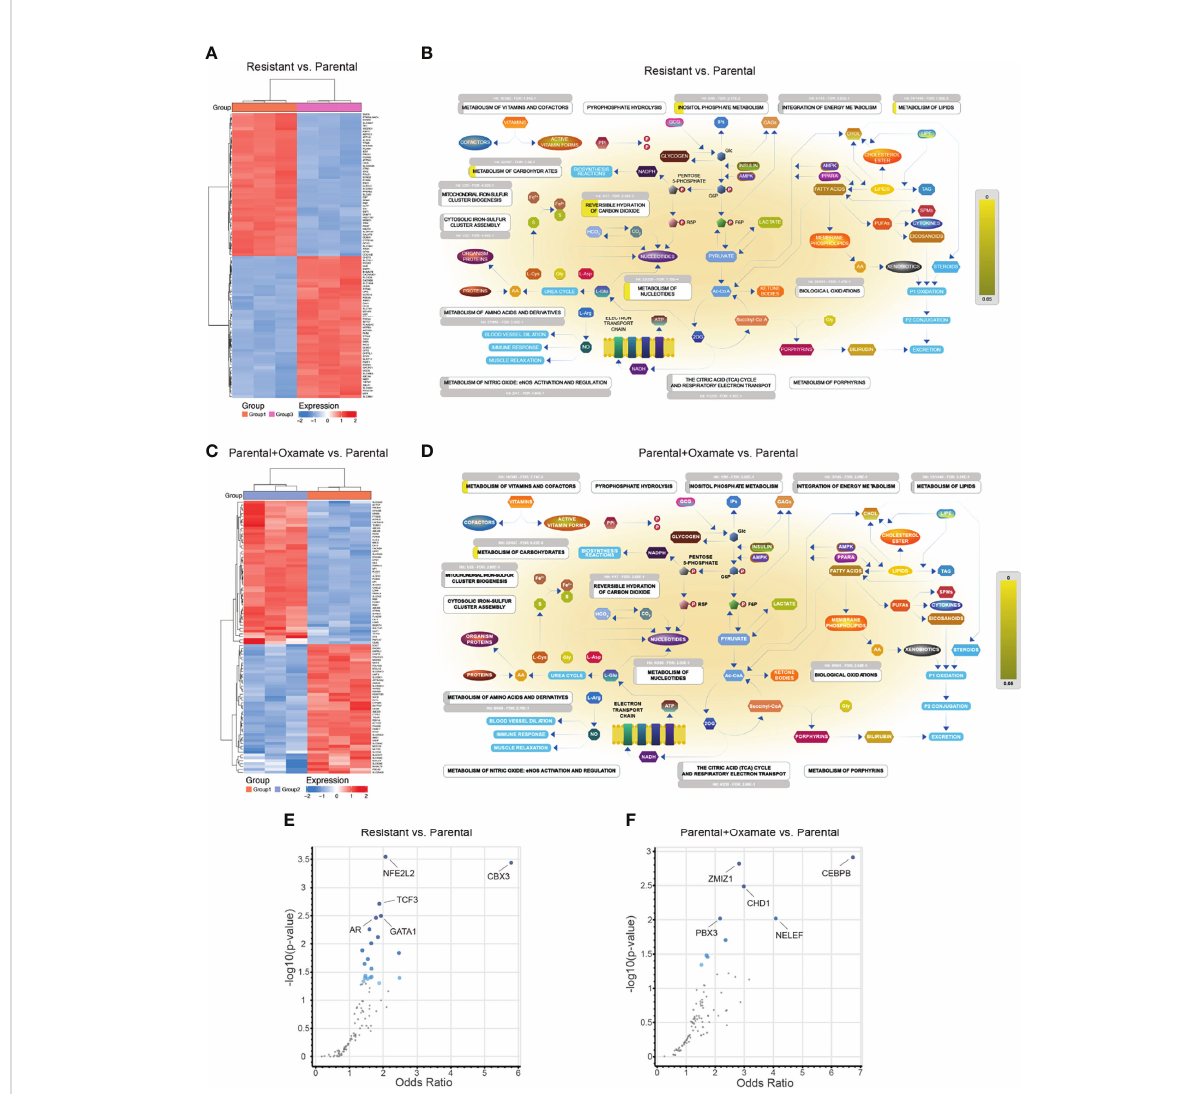
FIGURE 8 Alternations in metabolic genes and their potential transcriptional regulators in parental/resistant cells and parental/oxamate-treated parental cells. (A) Heatmap showing the expression of the top 100 (50 upregulated and 50 downregulated) differentially expressed metabolic genes between parental and oxamate-resistant MIAPaCa2 cells. (B) Reactome Pathway Analysis for differentially expressed metabolic genes between parental and oxamate-resistant MIAPaCa2 cells shows key metabolic pathways associated with signi fi cantly enriched genes (p-value <0.05, shown in yellow). (C) Heatmap showing the expression of the top 100 (50 upregulated and 50 downregulated) differentially expressed metabolic genes between vehicle- and oxamate-treated parental MIAPaCa2 cells. (D) Reactome Pathway Analysis for differentially expressed metabolic genes between vehicle- and oxamate-treated parental MIAPaCa2 cells shows key metabolic pathways associated with signi fi cantly enriched genes (p-value <0.05, shown in yellow). (E) Enrichr analysis using ENCODE and ChEA for identifying potential regulatory transcription factors involved in the differential expression of metabolic genes between parental and oxamate-resistant cells. (F) Enrichr analysis using ENCODE and ChEA for identifying potential regulatory transcription factors involved in the differential expression of metabolic genes between vehicle- and oxamate-treated parental MIAPaCa2